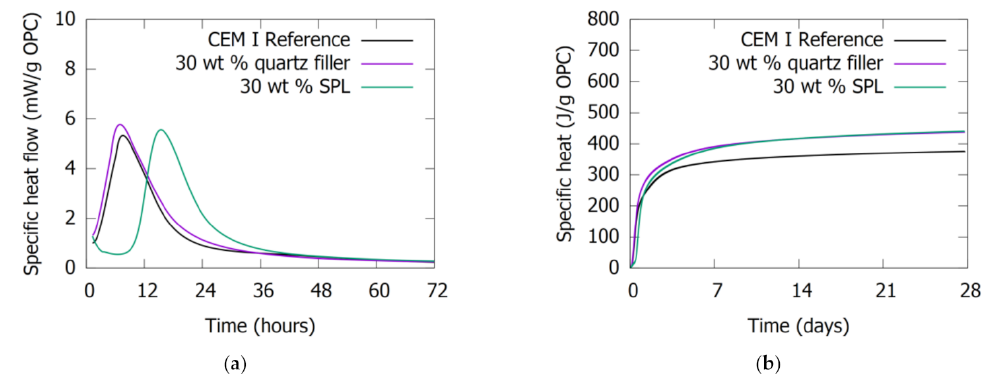
Figure 5. Heat flow ( a ) and cumulative heat ( b ) during isothermal calorimetry measurements. A measurement using 30 wt% spent pot lining aluminosilicates (70 wt% CEM I) is compared to references composed of 100% CEM I and 70 wt% CEM I with 30 wt% fine quartz filler.